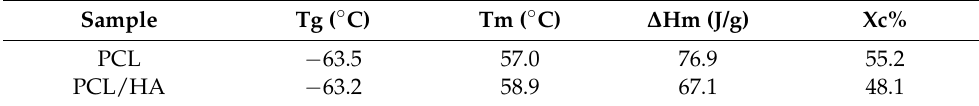
Table 3. Thermodynamics characteristics of PCL during second heating scan.